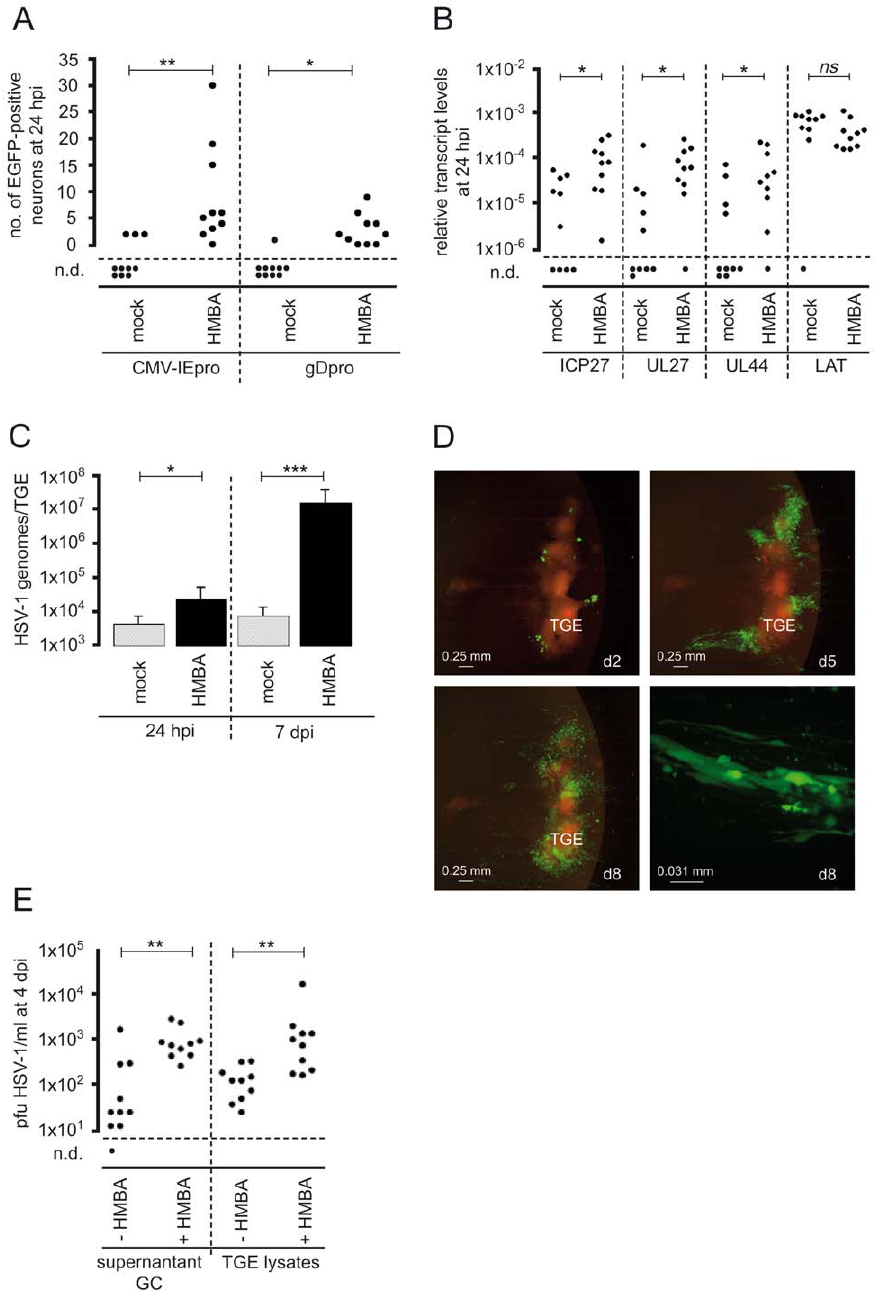
Figure 4. Stimulation of productive HSV-1 infection by HMBA. (A) EGFP expression in neurons in the AC at 24 hpi with 5 6 10 6 pfu of HSV-1 17 CMV-IEproEGFP and HSV-1 17 gDproEGFP in the presence of 2.5 mM HMBA. Mock-treated cultures are shown as controls. n.d., No EGFP-positive neurons detected. The statistical significances of variations in the median number of EGFP-positive neurons in HMBA-treated cultures relative to mock-treated cultures are indicated (HSV-1 17 CMV-IEproEGFP, P =0.0017; HSV-1 17 gDproEGFP, P =0.0132; Mann-Whitney test). (B) Effect of HMBA on HSV-1 transcript levels in axonally-infected TGEs at 24 hpi. TGEs were infected in the AC with 5 6 10 6 pfu of HSV-1 17 gDproEGFP. The statistical significances of differences in median transcript levels are indicated (ICP27, P =0.0089; UL27, P =0.0185; UL44, P =0.0355; LAT, P =0.1051; Mann- Whitney test). (C) Effect of HMBA on HSV-1 genome levels in axonally-infected TGEs. Groups of ten TGEs were infected in the AC with 5 6 10 6 pfu of HSV-1 17 gDproEGFP in the presence of 2.5 mM HMBA; mock-treated cultures served as controls. Genome levels were determined by qPCR at 24 hpi and 7 dpi. The statistical significances of differences in median genome levels are indicated (24 hpi, P =0.0115; 7 dpi, P =0.0002; Mann-Whitney test). Data are mean and SD values. (D) Spread of HSV-1 in axonally-infected TGEs in the presence of HMBA. TGEs were infected in the AC with 5 6 10 6 pfu of HSV-1 17 gDproEGFP in the presence of 2.5 mM HMBA and monitored daily for EGFP expression. The pattern of fluorescence in a culture with massive viral spread is shown at 2, 5, and 8 dpi (d2, d5, and d8, respectively). The bottom-right image depicts a group of HSV-1 infected nonneuronal cells at 8 dpi. (E) Effect of HMBA on the release of cell free virus. TGEs were infected in the GC with 1 6 10 4 pfu of HSV-1 17 gDproEGFP in the presence or absence of 2.5 mM HMBA as indicated in culture medium without CMC and HSV-1 antiserum. At 4 dpi, supernatants (supernatant GC) and TGEs were harvested and virus was titrated. Infectious virus was liberated from TGEs by repeated freeze-thawing in 100 m l PBS (TGE lysates).